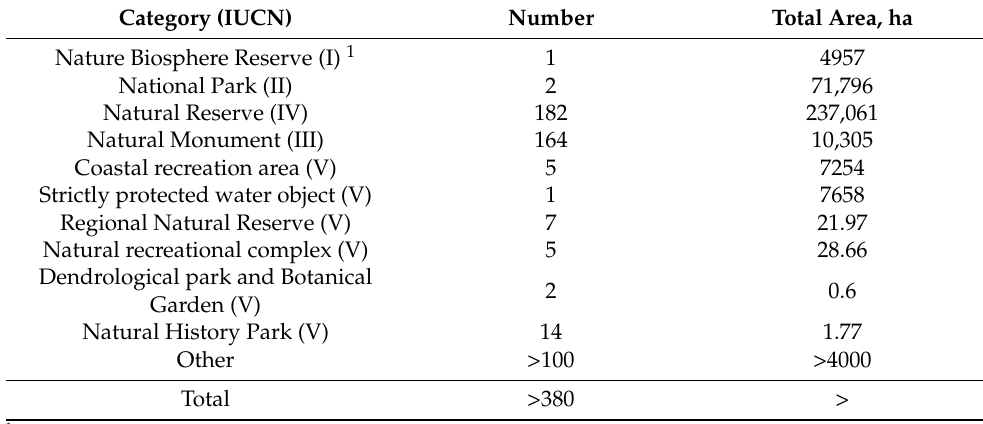
Table 1. Number and area of PAs in the